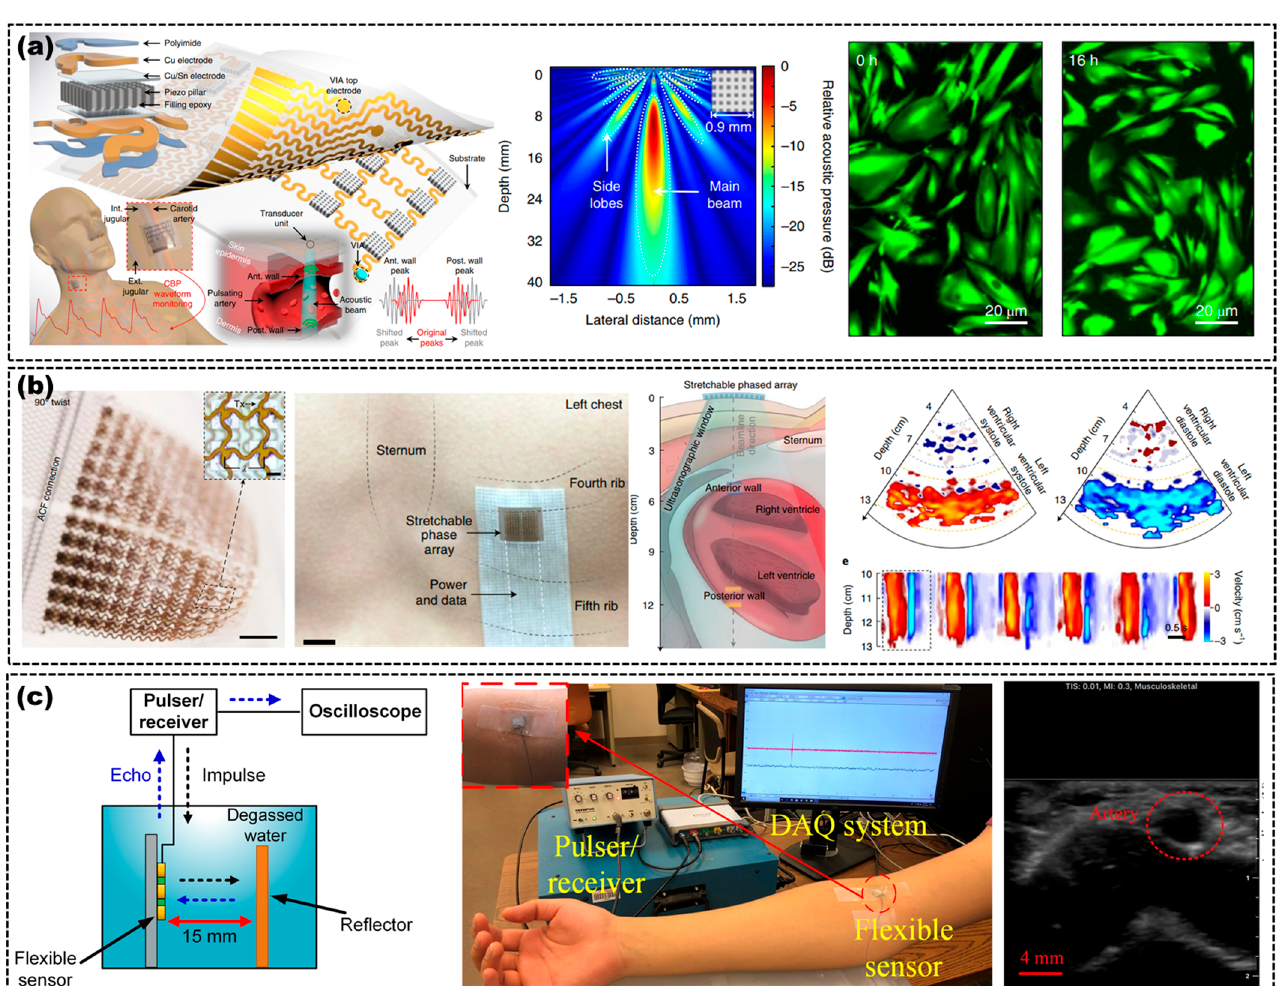
Figure 8. ( a ) Schematic of the transducer on the human chest ( left ), simulated acoustic emission profile of the transducer with excellent beam directivity and penetration depth ( middle ), and fluorescent images of the fibroblast cells before and after 16 h of continuous exposure to the transducer ( right ). Adapted from [56]. ( b ) Optical image of the US transducer ( left ), optical image of the transducer on the human chest (middle), and a schematic and the results of cardiac activity monitoring by the transducer ( right ). Adapted from [22]. ( c ) Schematic of the imaging system based on the flexible US transducer ( left ), an overview of the measurement configuration ( middle ), and the cine loop of US imaging of the ulnar artery ( right ). Adapted from [24].